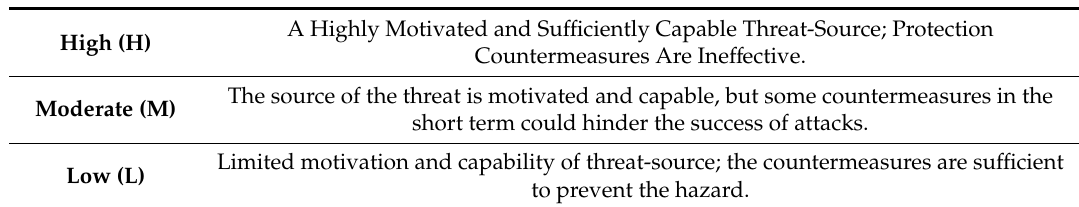
Table 3. Risk likelihood (chance